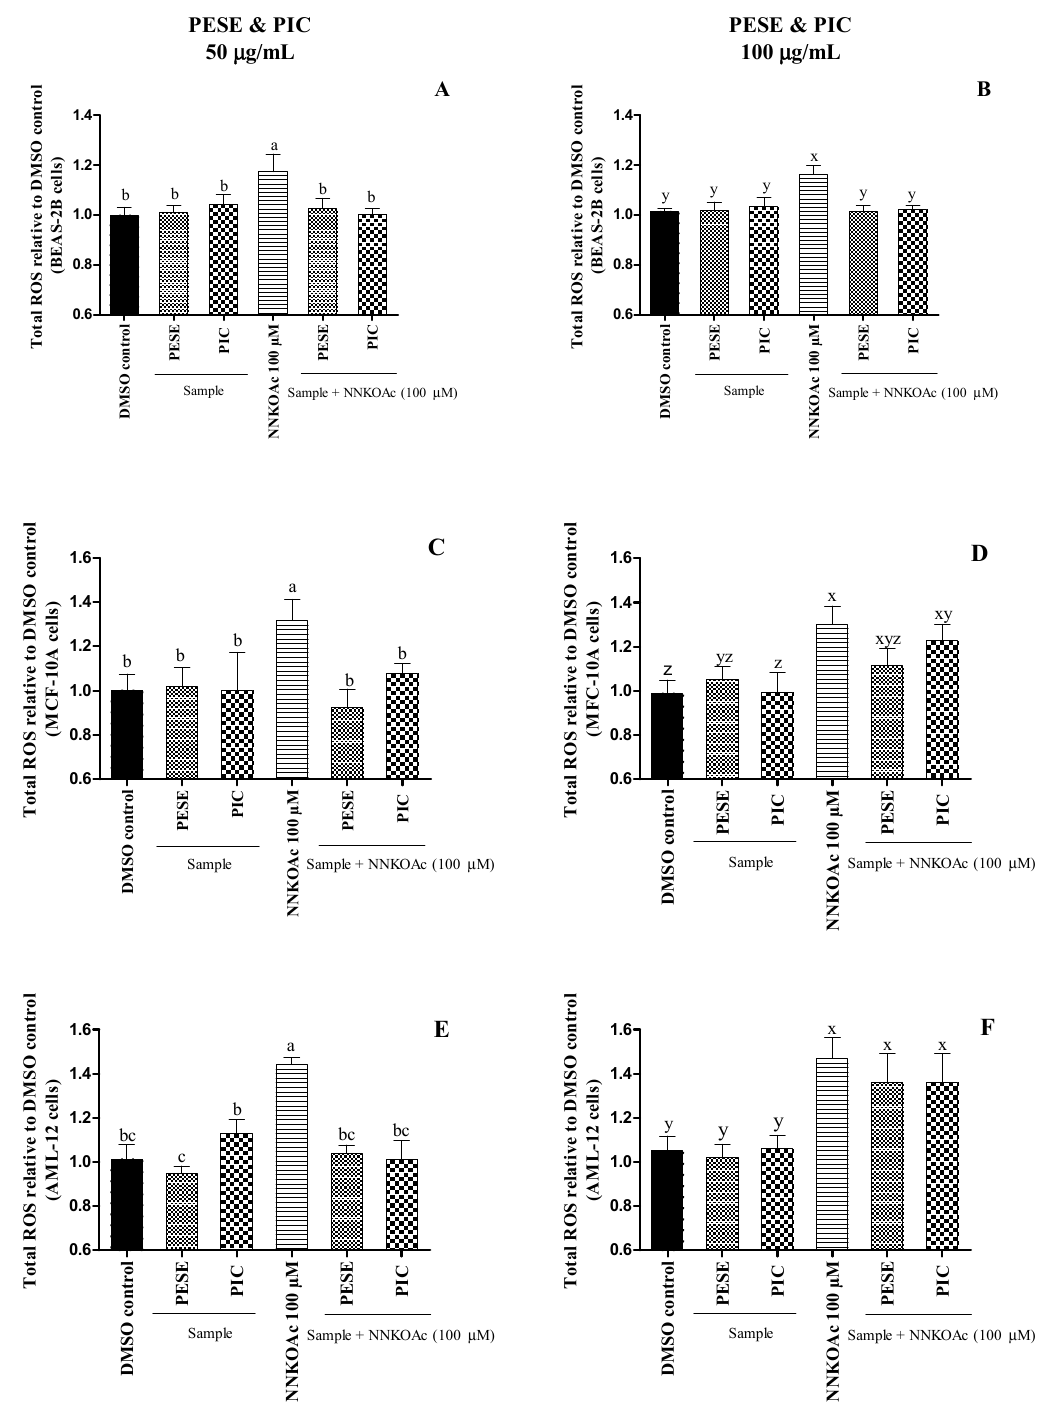
Figure 1. ( A – F ). The relative amount of reactive oxygen species (ROS) assessed on BEAS-2B, AML-12, and MCF-10A cell lines after exposure to either carcinogen alone or with pretreatment of PESE or PIC. All the treatment groups were compared to dimethyl sulfoxide (DMSO) control. a–c, x–z, mean ± SD followed by different letters represent significant differences (ANOVA analysis was per- formed followed by the Tukey test, p ≤ 0.05). Data are means of triplicates. Abbreviation: AML-12, alpha mouse liver 12; BEAS-2B, normal human bronchial epithelial cells; MCF-10, non-tumorigenic epithelial cells; DMSO, dimethylsulfoxide; NNKOAC, 4-[(acetoxymethyl)nitrosamine]-1-(3- pyridyl)-1-butanone; PESE, ethanolic extract of P. edulis seeds; PIC, piceatannol.